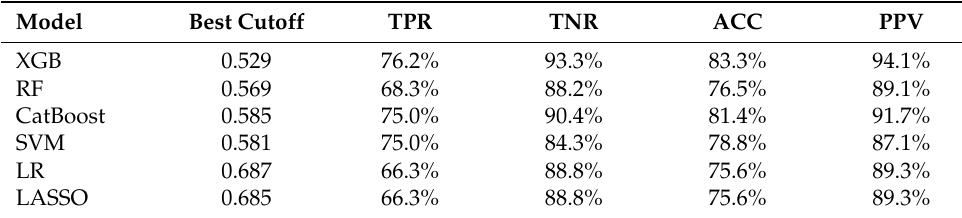
Table 7. Evaluation of authenticity of each model.